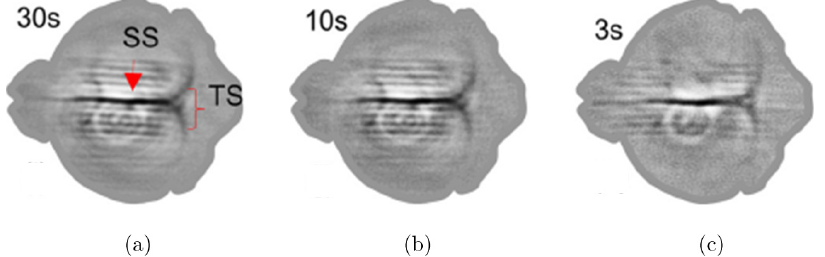
Fig. 2. In vivo imaging of rat brain in lateral plane at di®erent scanning speeds: (a) 30 s, (b) 10 s, and (c) 3 s, superior sagittal sinus (SS); transverse sinus (TS) (images adapted from Ref.